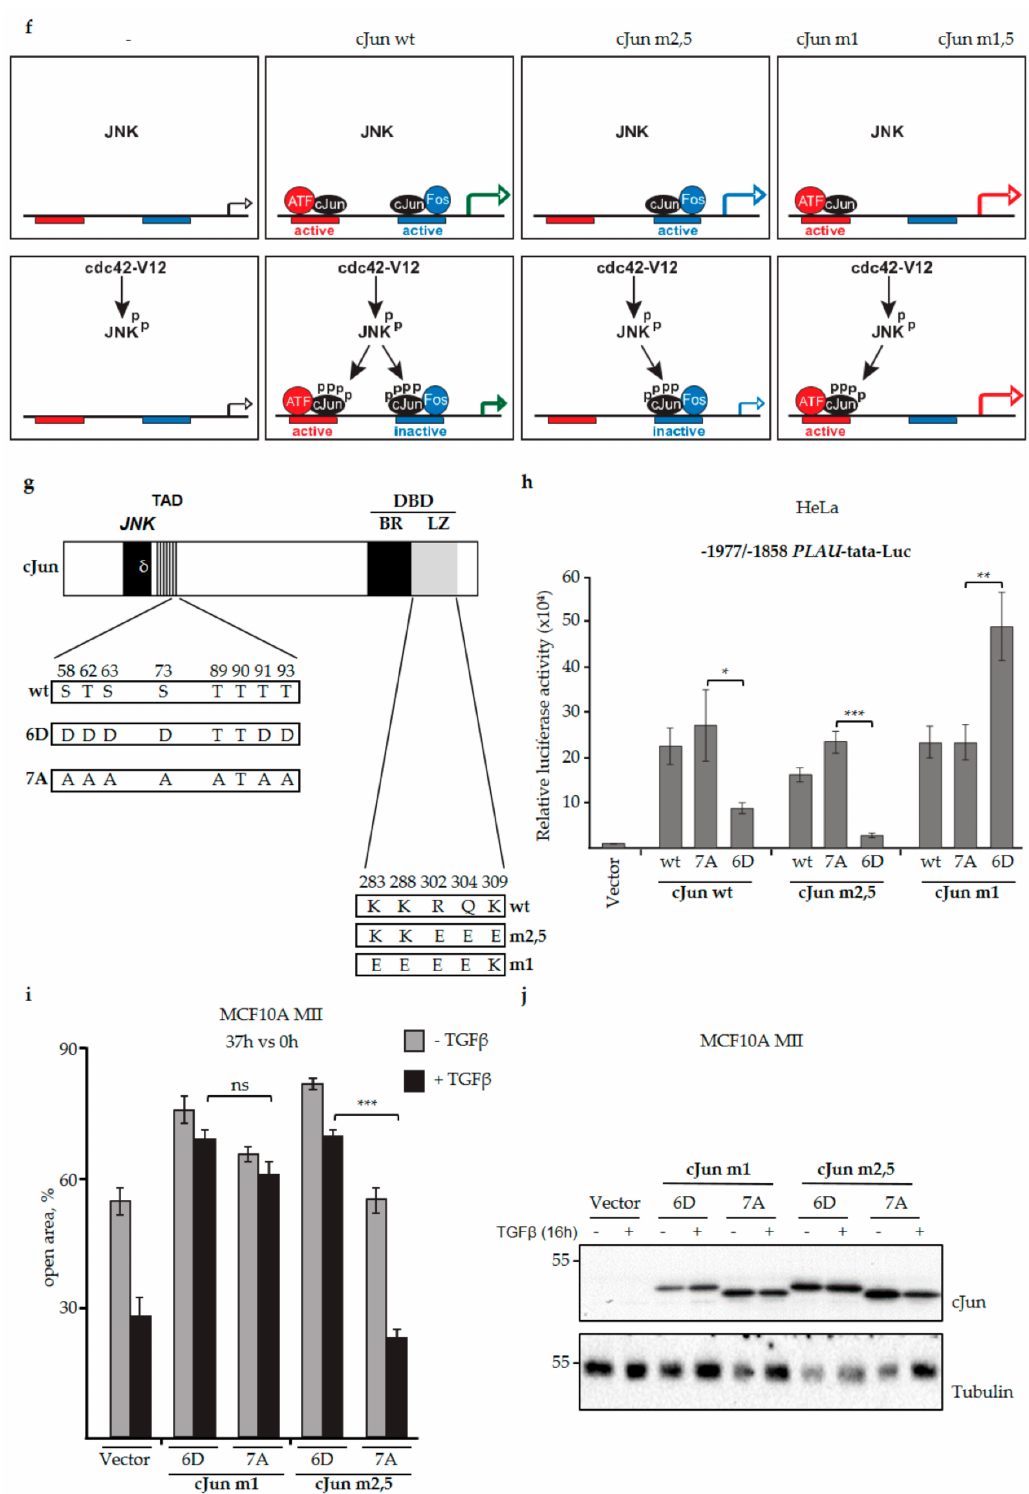
Figure 5. JNK-dependent hyperphosphorylation of cJun specifically inhibits gene activation and migration by Jun / Fos dimers. ( a ) cJun mutants with altered Jun / Fos and Jun / ATF2 dimerization specificities. Schematic representation showing the changes in the mutants m2,5, m1,5, and m1 compared to wt cJun. Numbers correspond to the positively charged cJun amino acid residues at the e and g positions of the cJun leucine zipper (LZ) α -helix that stabilize cJun / Fos heterodimers [60,74],